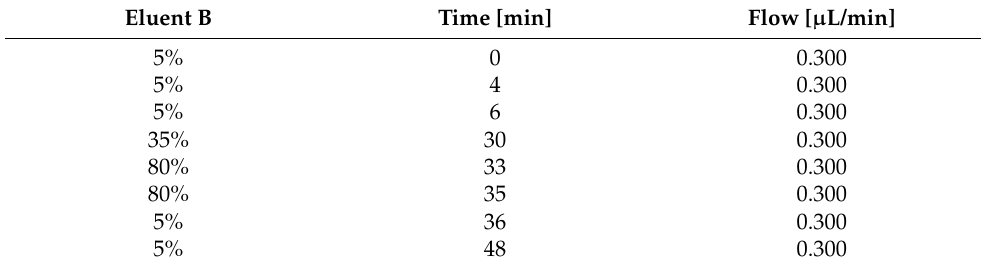
Table 1. Flow gradient for nanoLC separation. (A): water with 0.1 % v / v acetic acid, (B): acetonitrile with 0.1 % v / v acetic